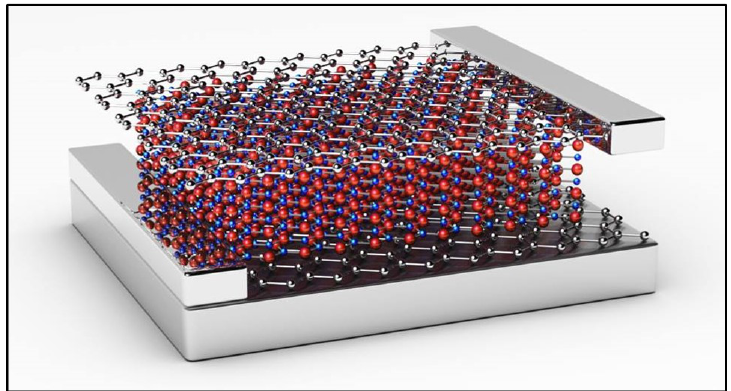
Figure 1. Graphene/boron nitride/graphene sandwich structure. Wide aluminum contacts are attached across the